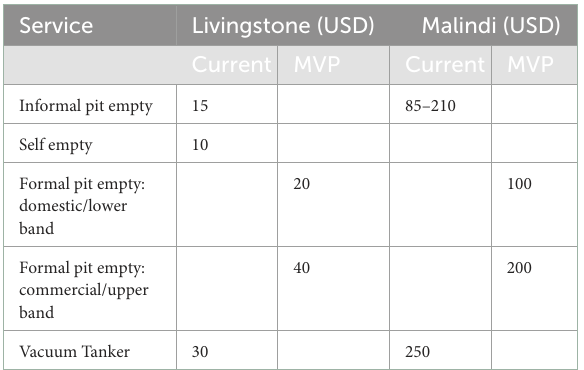
TABLE 5 Summary of pit emptying assessments and sales, as of August